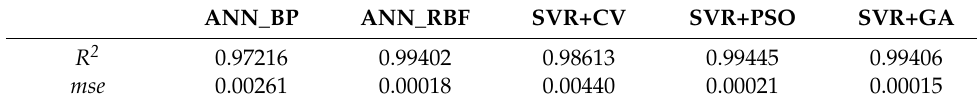
Table 3. The statistical performance comparison of test sets for T V u / 20 V u ratio.